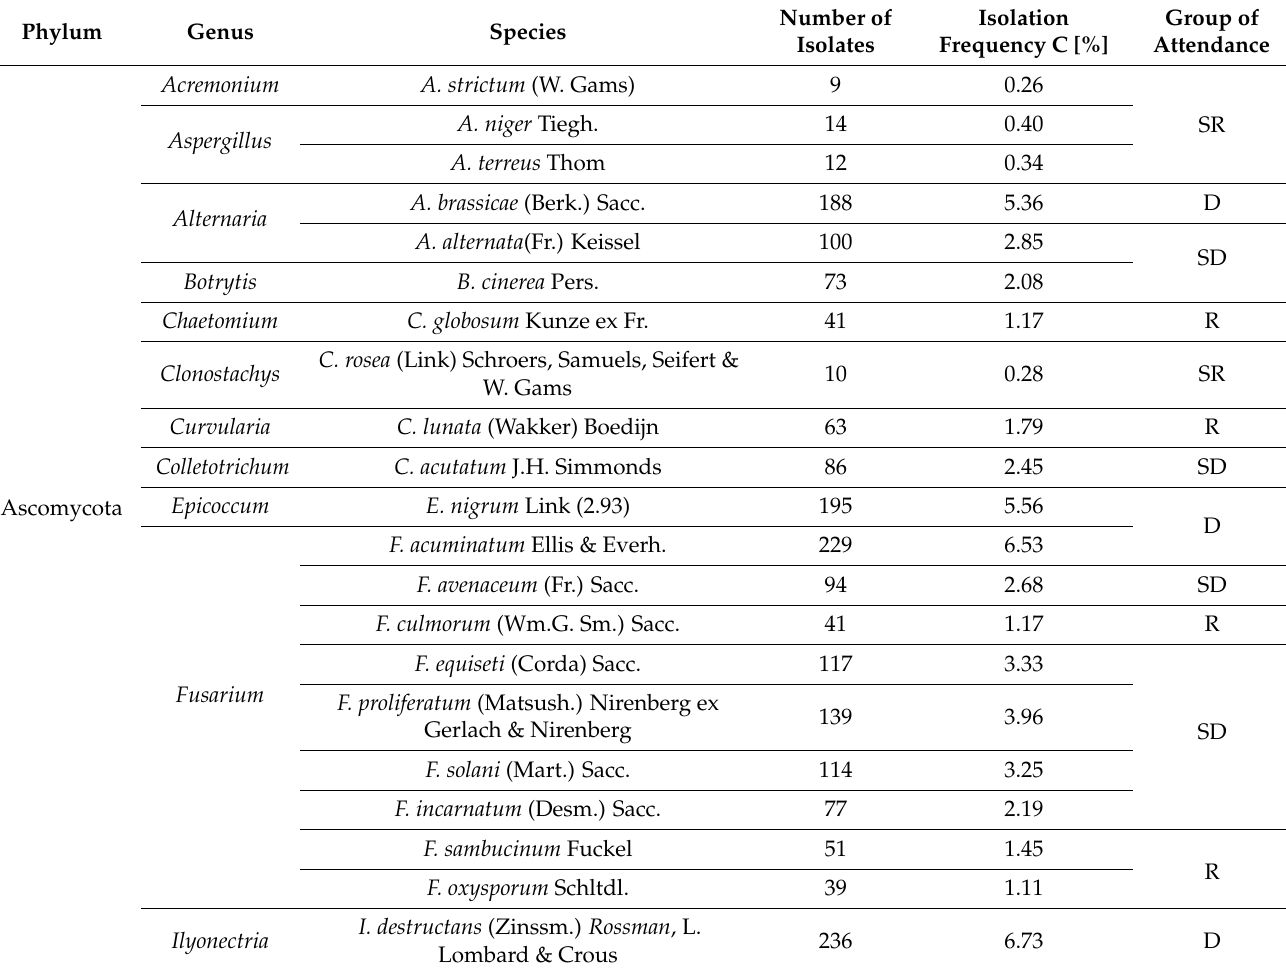
Table 4. List of species of microorganisms isolated from horseradish roots affected by Verticillium wilt in the years 2015–2017. Phylum Genus Species